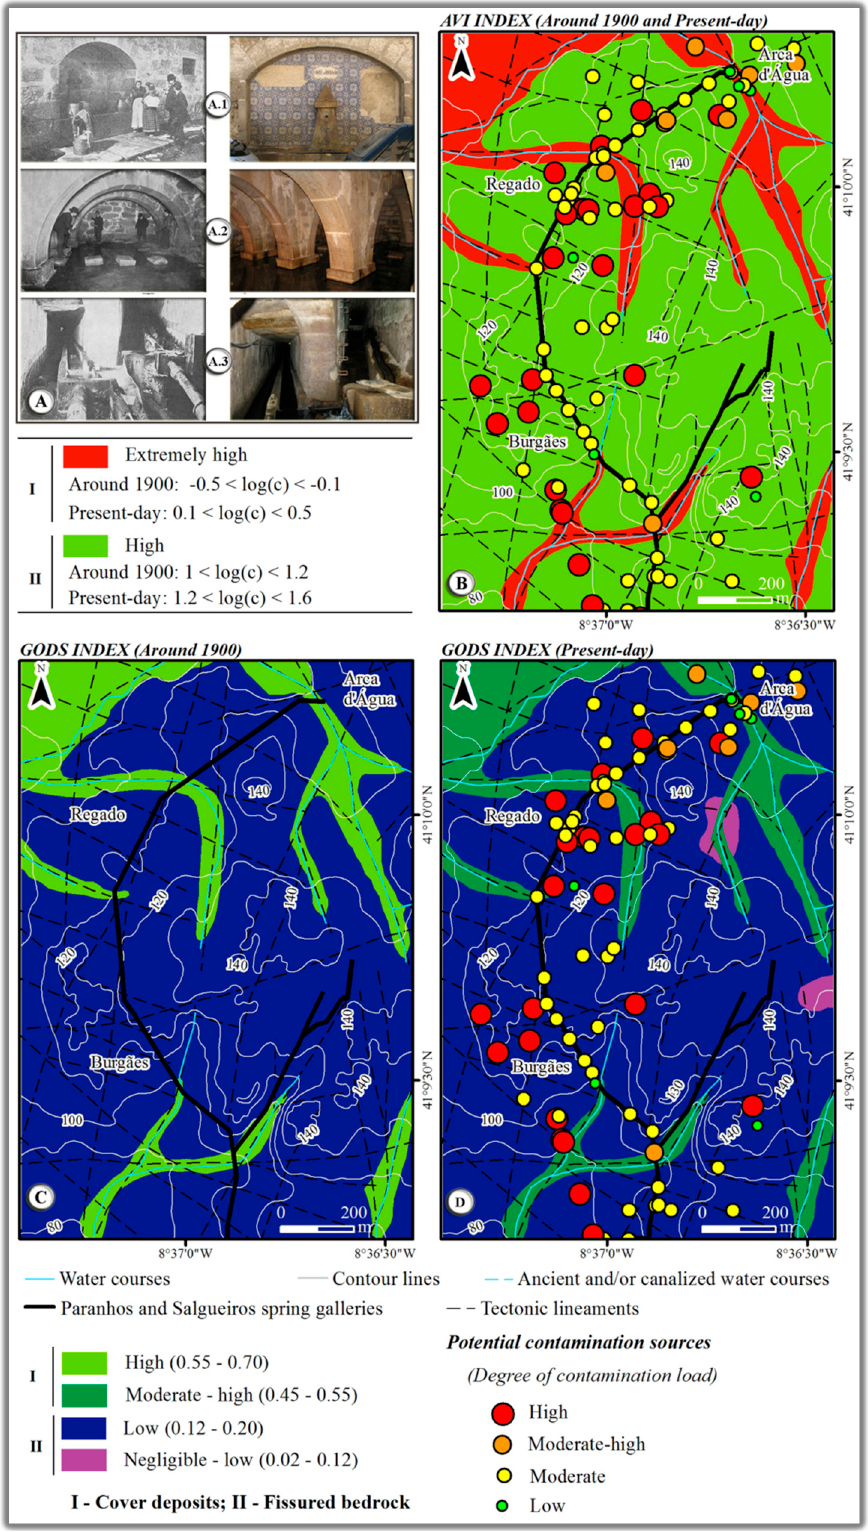
Figure 6. Some aspects of features related with Paranhos and Salgueiros spring galleries around 1900 and at present-day; ( A.1 ) Regado fontain; ( A.2 ) Arca d’Água reservoir; ( A.3 ) confluence of the Paranhos and the Salgueiros galleries; AVI ( B ) and GODS ( C , D ) vulnerability maps, and potential contamination sources for the present-day scenario.